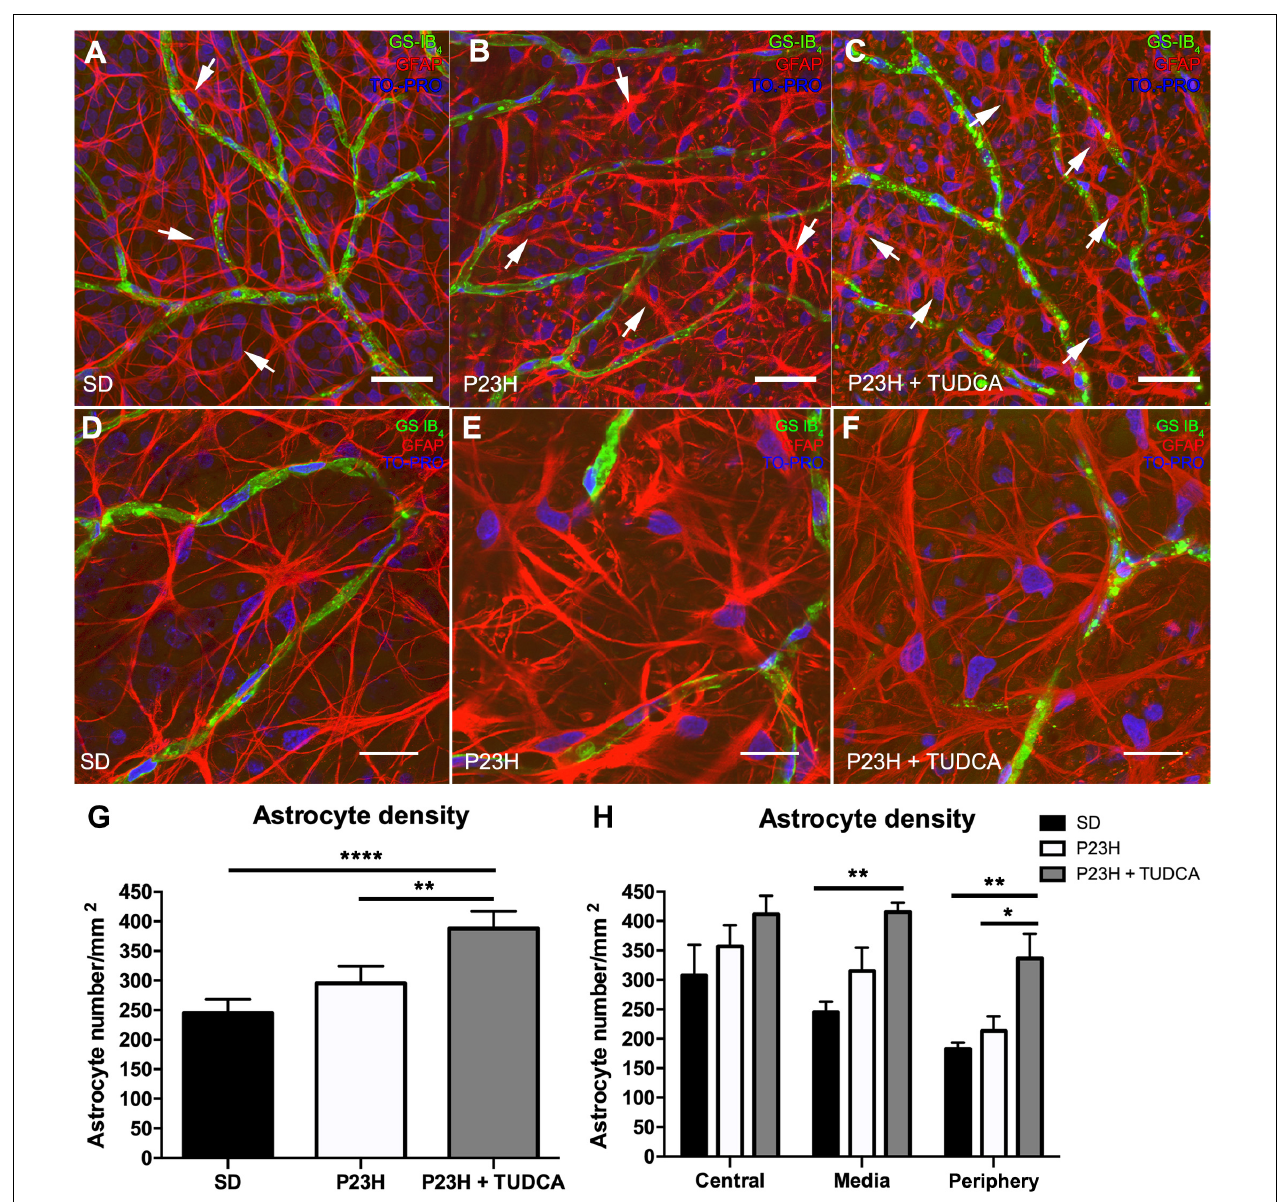
FIGURE 4 | Tauroursodeoxicholic acid (TUDCA) effects on retinal astrocyte density, distribution, and morphology in P23H rats. Whole mount retinas from an SD (A) , P23H (B) , and TUDCA-treated P23H (C) rat at P120, showing the distribution of retinal astrocytes (Glial Fibrillary Acidic Protein, GFAP; red, arrows) associated with SCP vessels (isolectin GS-IB 4 ; green) at the nerve fiber layer. Nuclei were stained with TO-PRO 3 iodide (blue). Images were taken from the medial retina. Note the presence of GFAP-positive Müller cell end-feet in vehicle- and TUDCA-treated P23H retinas (B,C) . (D–F) High magnification view of astrocytes (GFAP, red) and SCP vessels (isolectin GS-IB 4 ; green). Note that astrocytes in P23H retinas (E) show thickened processes and gliotic features (increased staining for GFAP and hypertrophy) compared to SD retinas (D) , and that TUDCA treatment (F) reduce these changes. (G) Mean retinal astrocyte density in the three experimental groups. (H) Mean density values in the central, medial, and peripheral retina. Scale bare: 40 µ m (A–C) and 20 µ m (D–F) . One-way (G) and two-way (H) ANOVA, Tukey’s multiple comparison test; * p < 0.05, ** p < 0.01, **** p < 0.0001. SD: n = 3, P23H: n = 3, P23H + TUDCA: n =